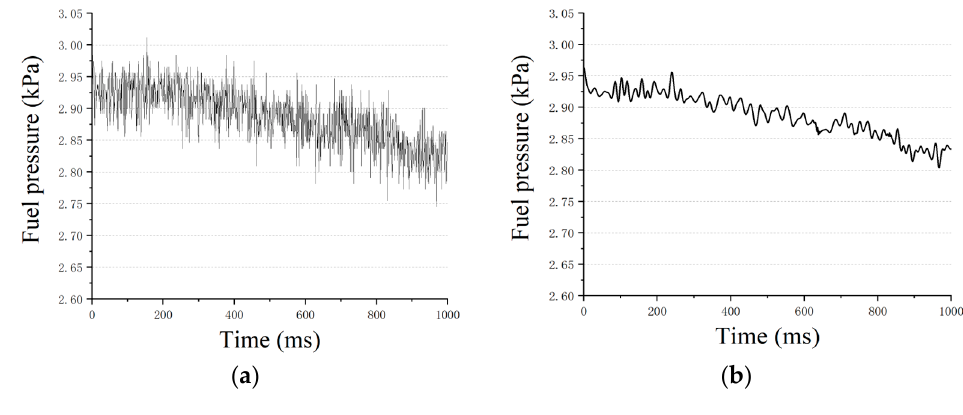
Figure 9. ( a ) The high − frequency signal ( left ) and the low − frequency signal ( right ) after the first − level decomposition; ( b ) The high − frequency signal ( left ) and the low − frequency signal ( right ) after the second − level decomposition; ( c ) The high − frequency signal ( left ) and the low − frequency signal ( right ) after the third − level decomposition.